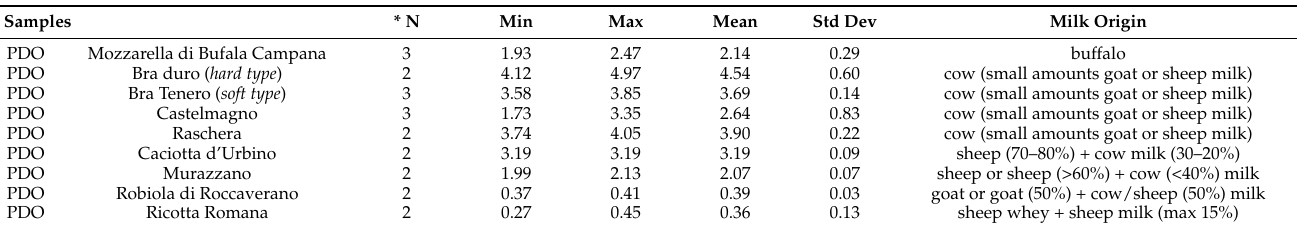
Table 3. Zinc content in PDO Italian cheeses from buffalo milk, from mixed milk, and from sheep whey (mg/100 g). Samples